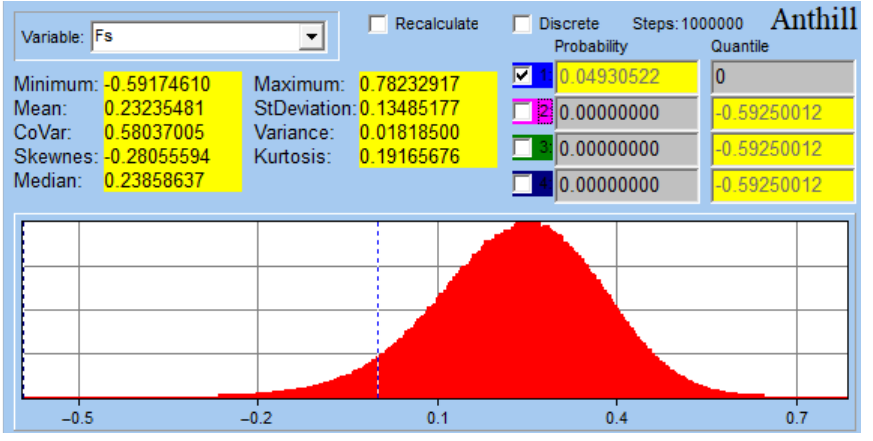
Figure 9. Distribution of the reliability function Fs — Anthill software.